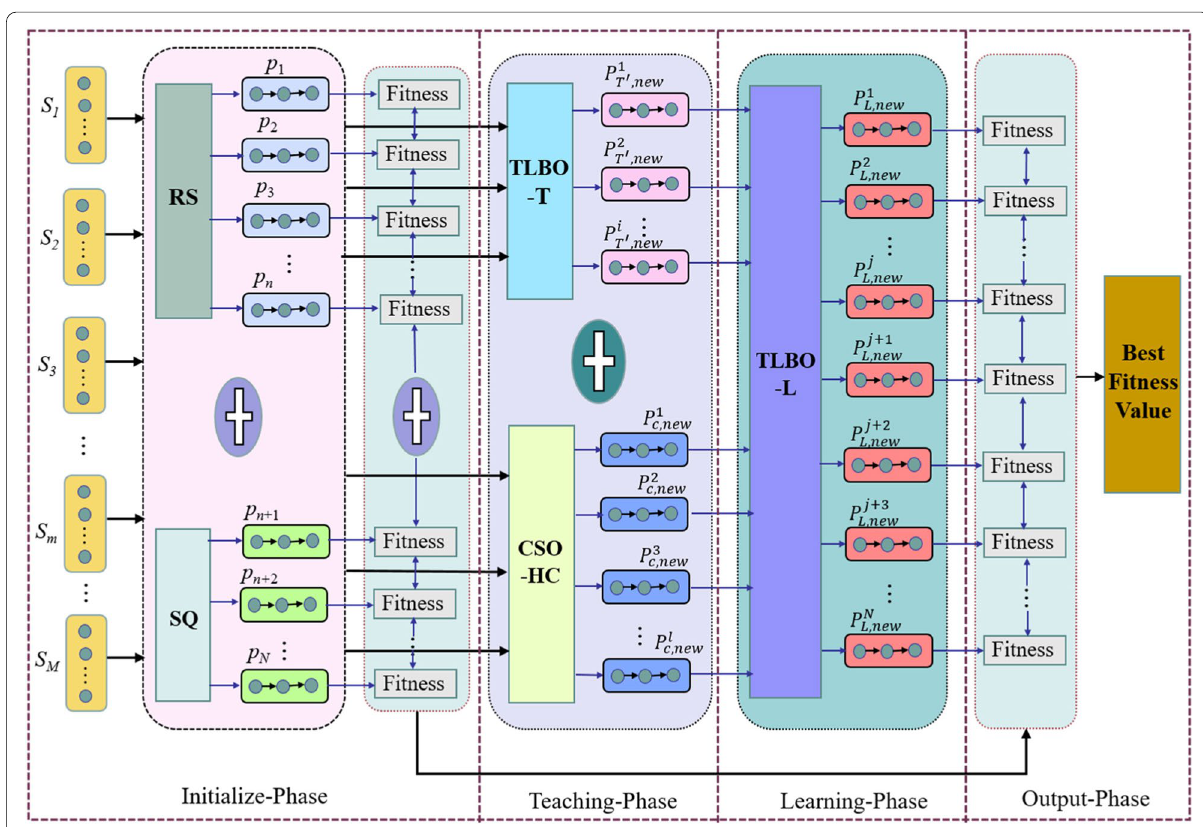
Fig. 2 Framework of the proposed improved-TC, RS is Random Selection, SQ is Skyline Query, TLBO-T is TLBO-Teaching, CSO-HC is CSO-Horizontal Crossover and TLBO-L is